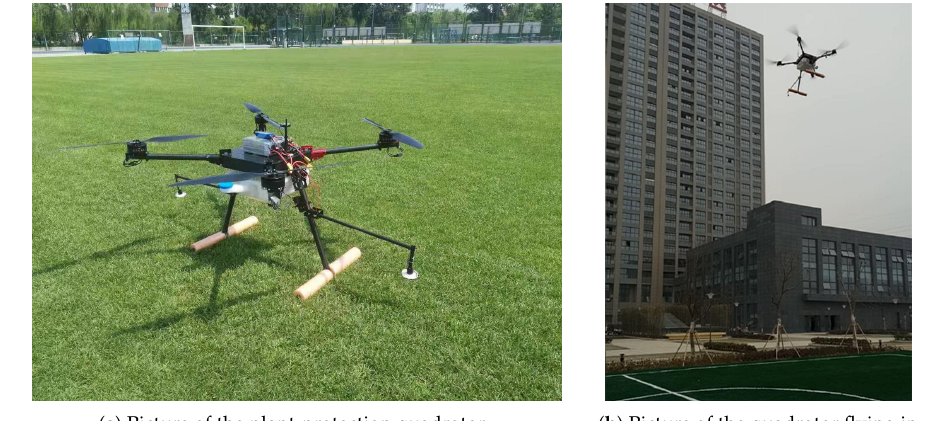
Figure 14. The 10 kg class large-load plant-protection quadrotor in this article.